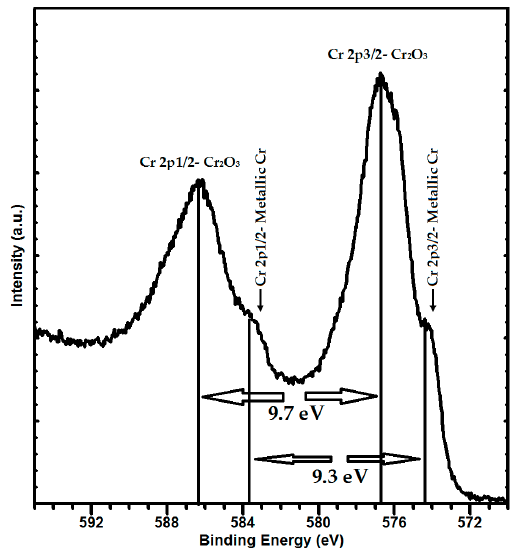
Figure 7. The high-resolution Cr 2p XPS spectrum of coatings deposited at 300 Cr-target voltages.